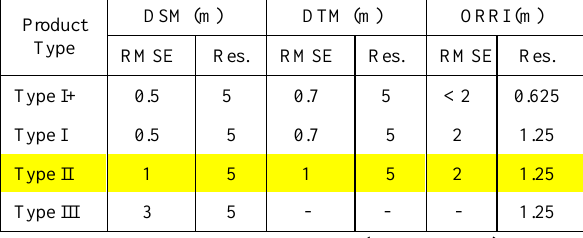
Table 2. IFSAR Product Type (Mercer,